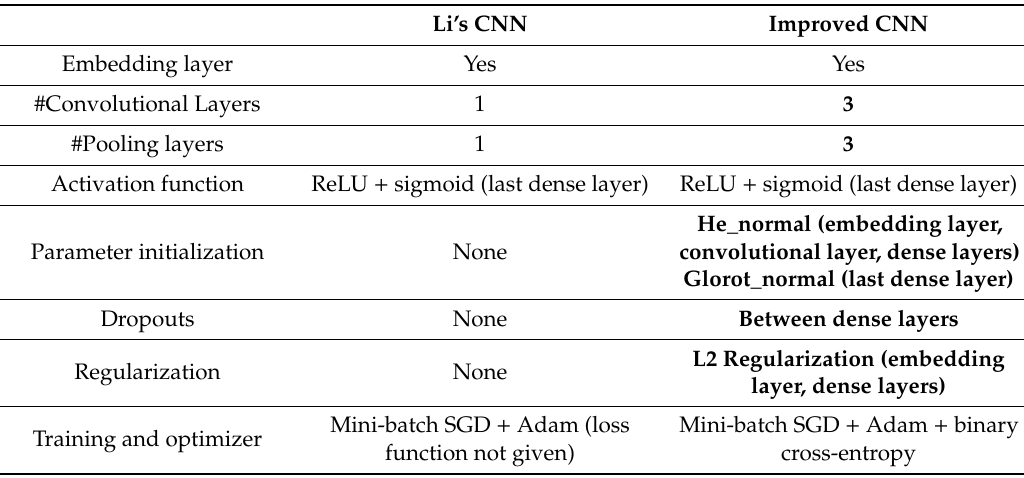
Table 1. Architectural comparison between Li’s CNN model and our improved CNN model. Di ff erences are highlighted in